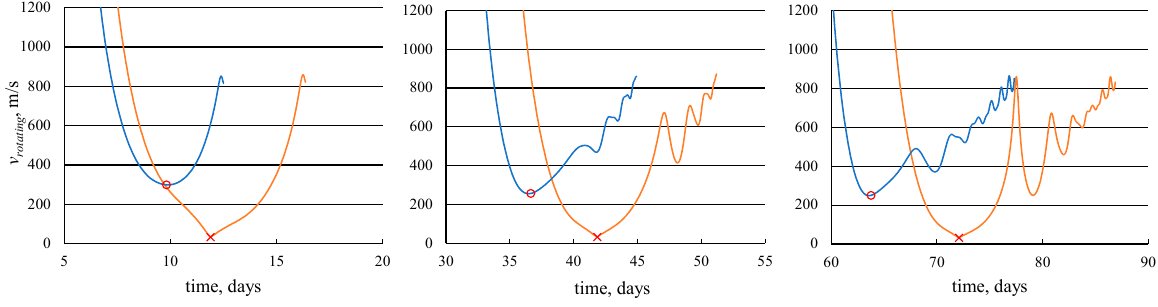
Figure 5. The time dependences of the velocity in the rotating coordinate system on the 5-(on the left), 20-(in the middle), and 35-revolution (on the right) trajectories with an optimal junction point and with an intermediate EML 1 rendezvous.